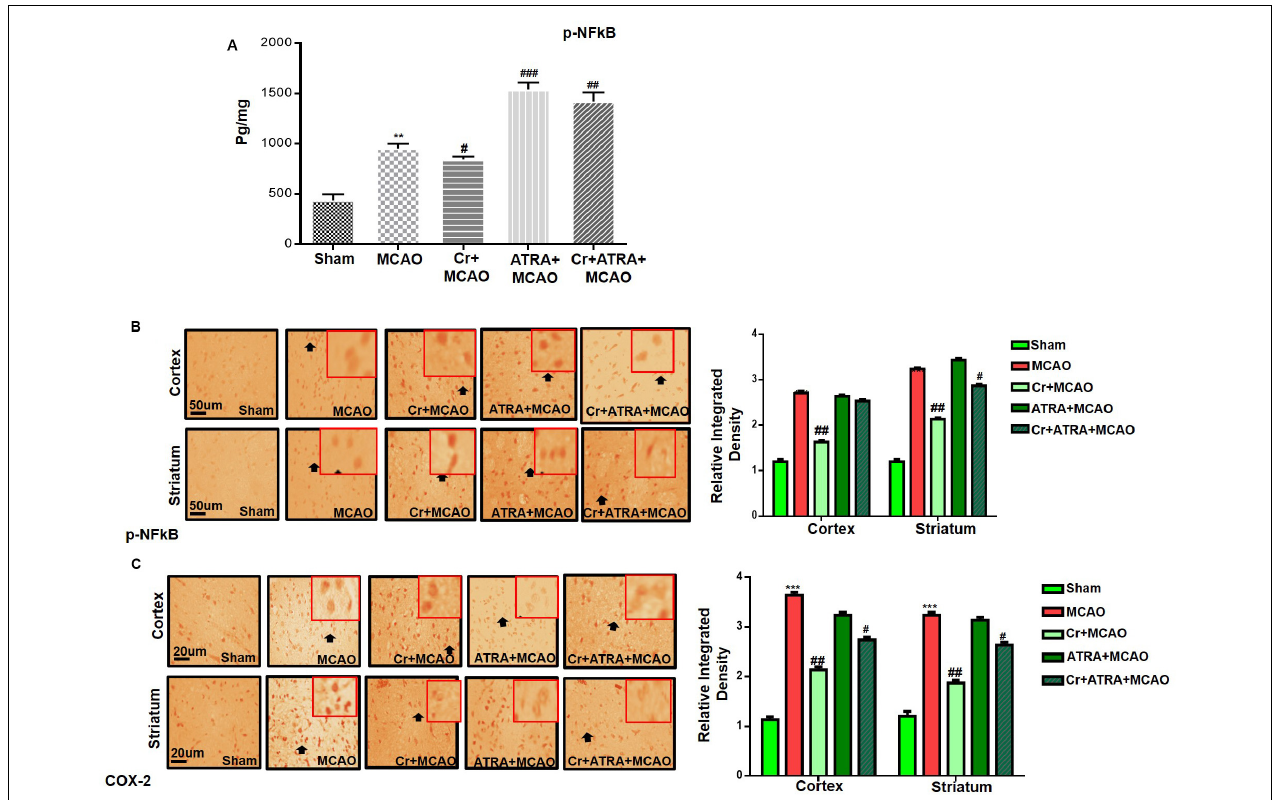
FIGURE 7 | Effect of carveol (20 mg/kg) on outcomes of MCAO induced inflammatory mediators. (A) The protein expression of p-NF κ B was quantified by ELISA in the brain cortex. The data were expressed as the mean ± SEM and were analyzed by one-way ANOVA with n = 5/group. ** p < 0.001 shows difference relative to sham while # p < 0.05, ## p < 0.01, and ### p < 0.001 shows significant difference relative to MCAO. (B) Immunohistochemistry results for p-NF κ B in cortex and striatum tissues of the brain. Scale bar 50 µ m, magnification 40 × . (C) Immunohistochemistry results for COX-2 in the cortex and striatum tissues of the brain. Scale bar 50 µ m, magnification 40 × ( n = 5/group). p-NF κ B exhibited nucleus localization while COX-2 exhibited cytoplasmic localization in both tissues of the brain. Histograms show comparatively higher expression of p-NF κ B and COX-2 in various segments of the MCAO and ATRA groups. *** p < 0.001 shows significant difference relative to sham, while # p < 0.05 and ## p < 0.01 shows significant difference relative to MCAO group. Data are presented as means ± SEM. Data is analyzed by two-way ANOVA followed by post hoc Bonferroni multiple comparison test using GraphPad Prism 6 software. Immuno slides were made by processing TTC thick coronal sections which were fixed in 4% paraformaldehyde. From the thick coronal TTC sections, paraffin blocks were made and later 4 µ m thin coronal sections were prepared by a rotary